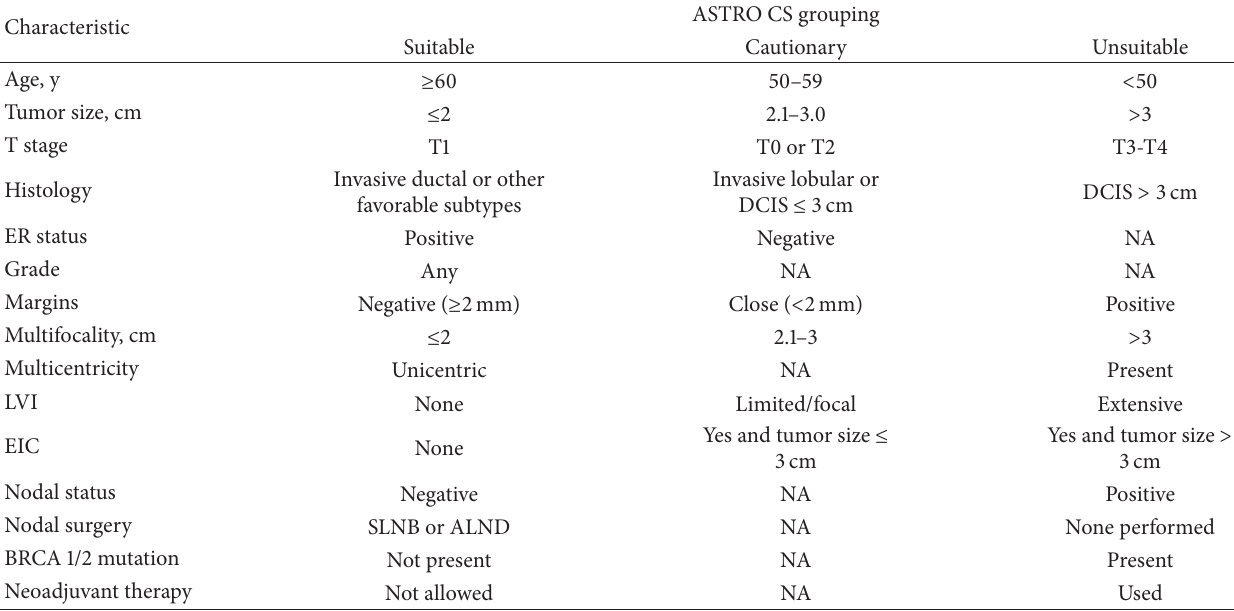
Table 1: American Society for Radiation Oncology (ASTRO)